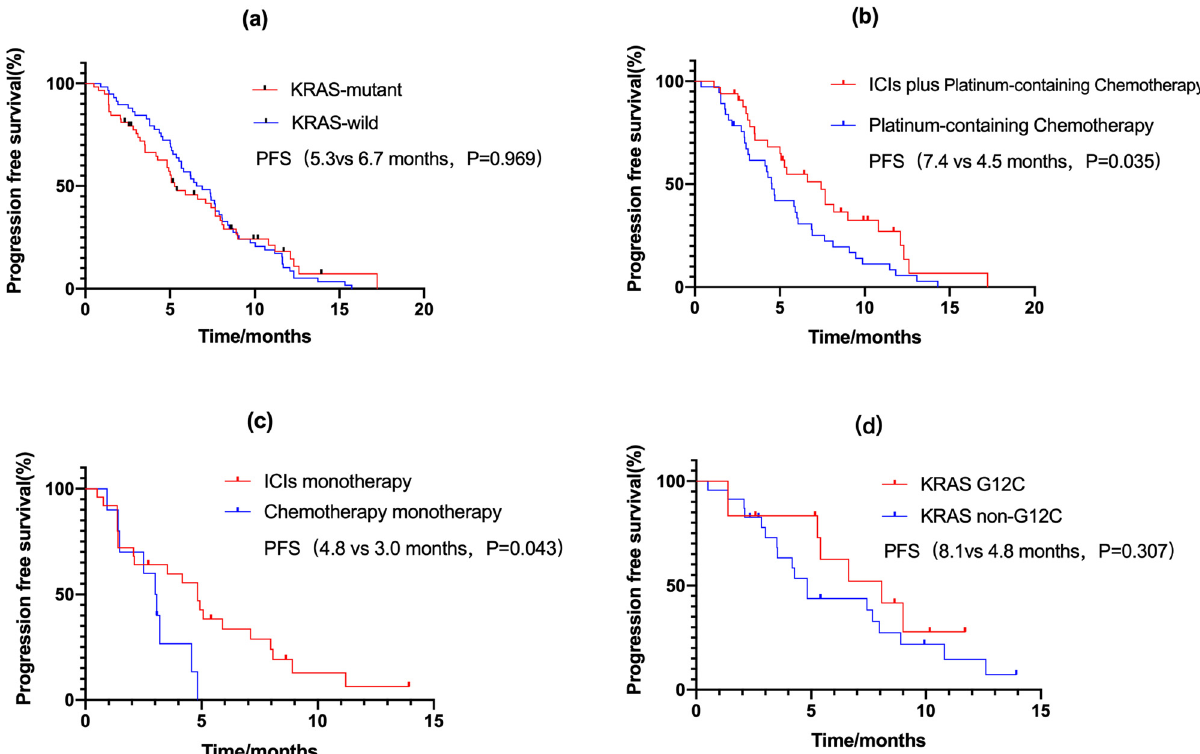
Figure 1: PFS ( a ) PFS of KRAS - mutant and KRAS - wild type; ( b ) PFS of fi rst - line; ( c ) PFS of second - line; ( d ) PFS of KRAS - mutant subtypes. PFS: progression - free